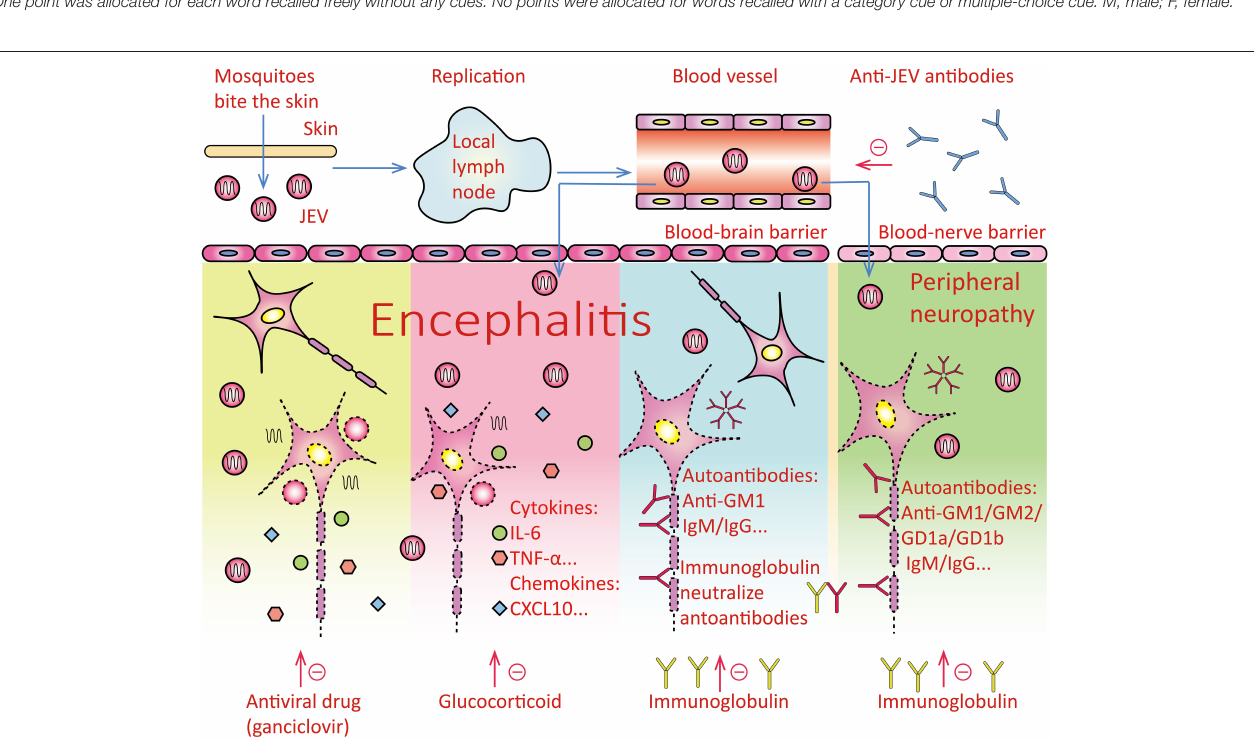
FIGURE 4 | Overview of pathogenesis and therapeutic drugs of Japanese encephalitis. Pathogenesis of disease: After the mosquito bites the human skin, it enters the lymph nodes and replicates in the lymph nodes, and then enters the blood system to form viremia, which stimulates the body to produce protective antibodies against the Japanese encephalitis virus. The virus mainly causes the following three aspects of damage, and the three drugs act on the following three aspects respectively. 1. The virus penetrates the blood-brain barrier and enters the central nervous system. The virus directly damages neurons. The antiviral drug ganciclovir may inhibit the replication of Japanese encephalitis virus and reduce the damage of the virus to neurons. Antiviral drugs may act on this pathogenesis. 2. After the virus enters the human body, the body produces IL-6, TNF- α , TLRs, and other cytokines and chemokines, causing inflammation of the whole body and brain parenchyma. Glucocorticoids fight inflammation. 3. The composition of the virus may be similar to that of the central nervous tissue, which stimulates the body’s immune system to produce autoantibodies against its nervous tissue components, such as Anti-GM1 IgM/IgG and so on. The virus can also stimulate the body to produce autoantibodies against peripheral nerve tissue components, such as Anti-GM1 IgM/IgG, Anti-GM2 IgM/IgG, Anti-GD1a IgM/IgG, Anti-GD1b IgM/IgG, etc. Intravenous immunoglobulin mainly contains